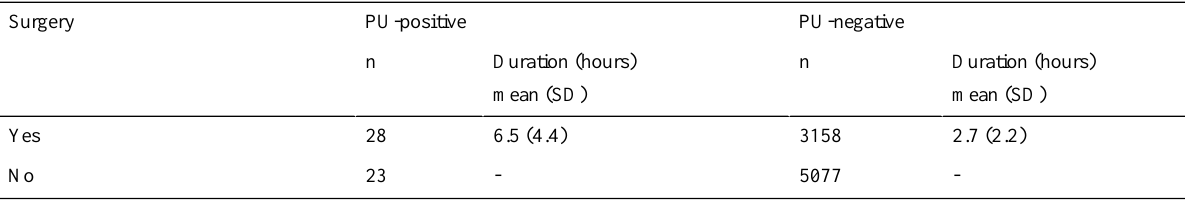
Table 3. Descriptive statistics of patient surgical duration.